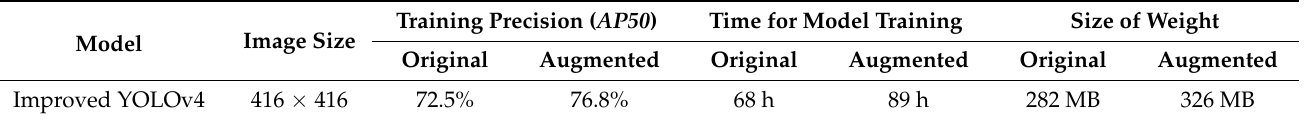
Table 4. Fruit and vegetable classification model training precision for original (12,000) and aug- mented images (43,667).